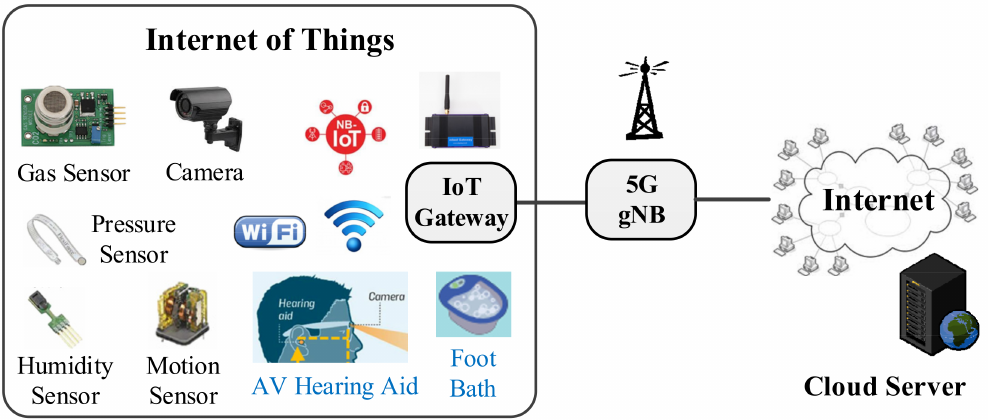
Figure 1. Potential applications of IoT within 5 G